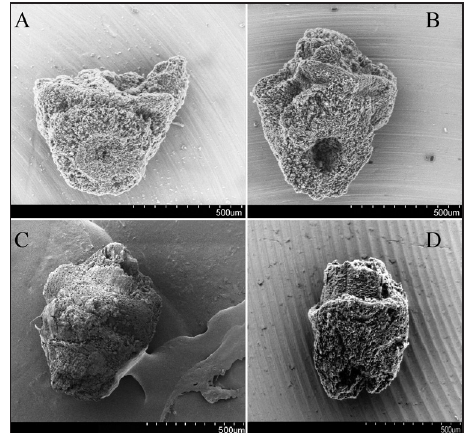
Figure 2: Examples of archaeological